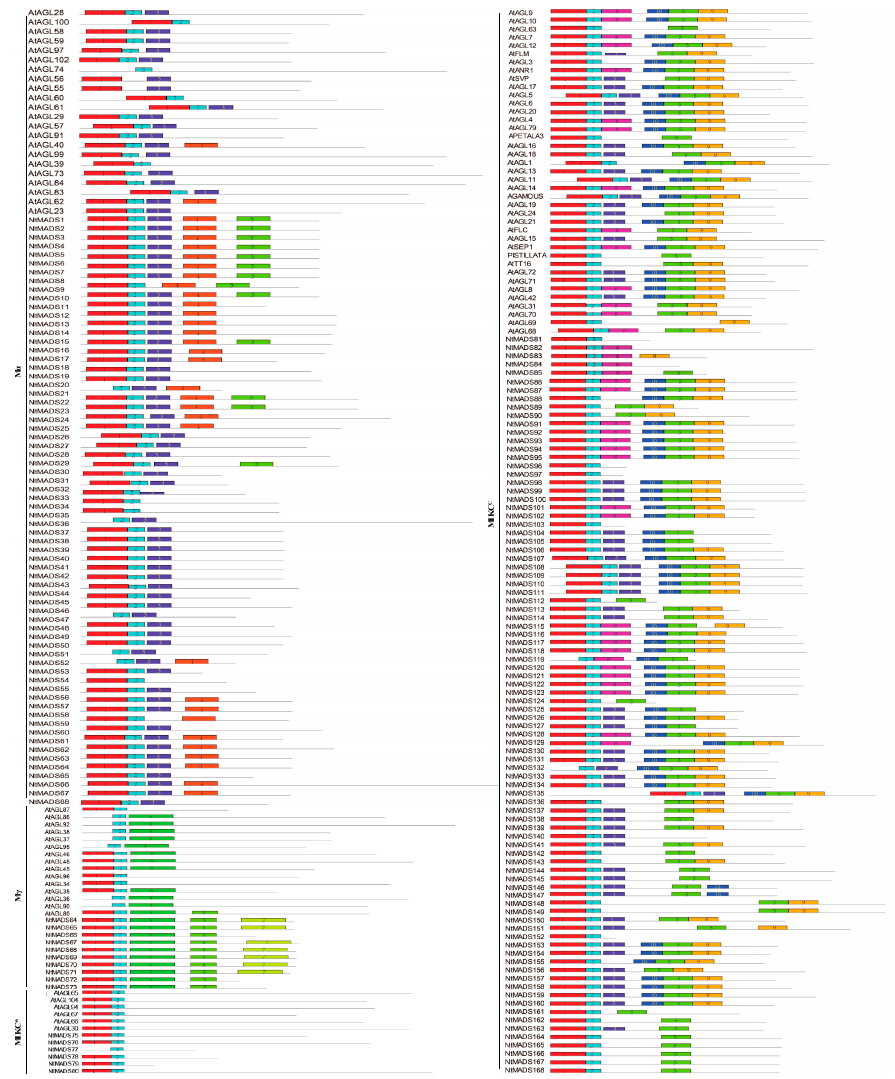
Figure 3. Conserved motifs of MADS-box genes in tobacco and Arabidopsis were predicted by MEME. Grey lines represent the non-conserved sequences, and ten conserved motifs are indicated by different colors with numbered boxes.